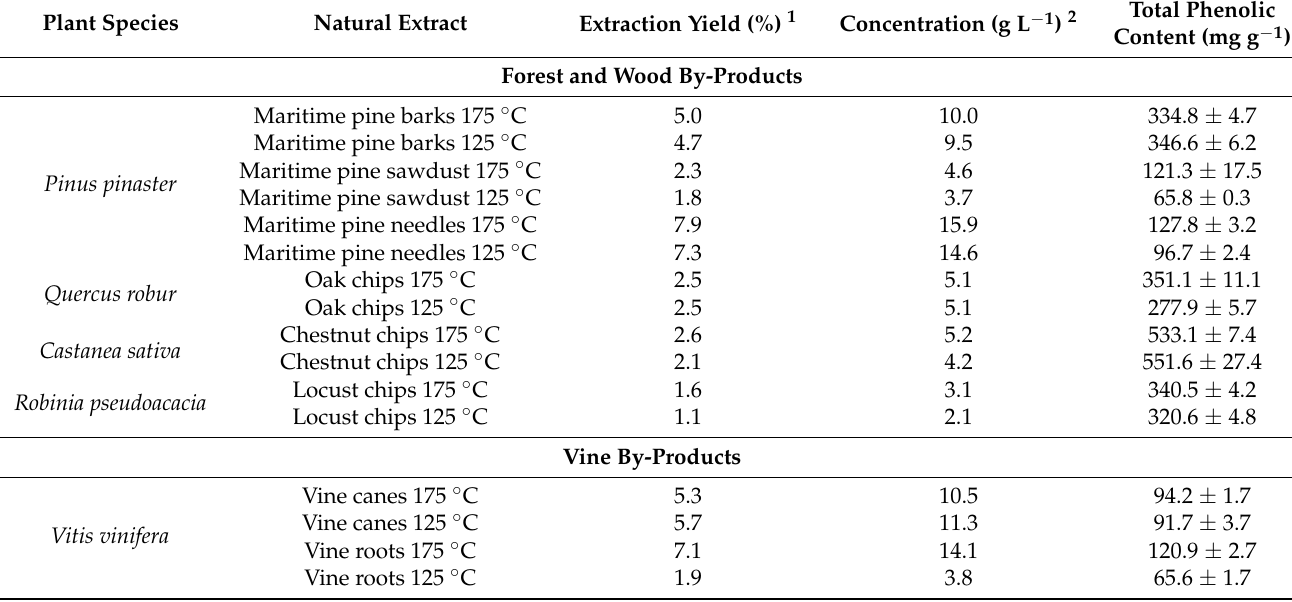
Table 1. Origin, extraction yield, concentration, and total phenolic content of natural extracts. Plant Species Natural